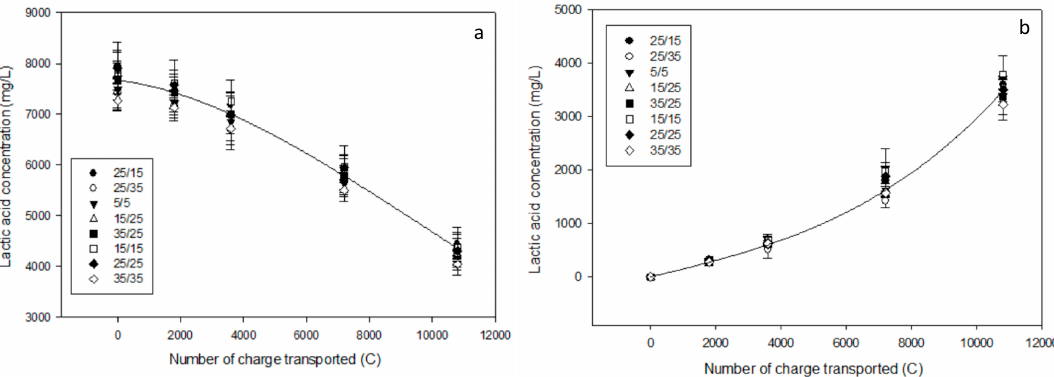
Figure 3. Evolution of lactic acid and lactate concentration (in mg / L) during electrodialysis in ( a ) the AWComp and ( b ) OAComp for all PEF conditions tested.